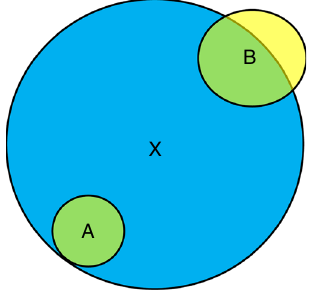
Fig. 5 Schematic illustration of stress amelioration for plants with different size in a zone-of-in fl uence (ZOI) model. A and B (yellow ZOIs) are two conspeci fi c bene fi ciary plants and they are facilitated by a benefactor X (blue ZOI). The stress intensity (e.g., salinity) per unit area is homogeneous across space. The area of overlap of ZOIs (green) is the same for both bene fi ciary plants ( A fa = A fb ). However, plant A fully bene fi ts from the presence of X while B bene fi ts only partly. Thus, bene fi ciary A will respond more positively to habitat amelioration than bene fi ciary B, i.e.,